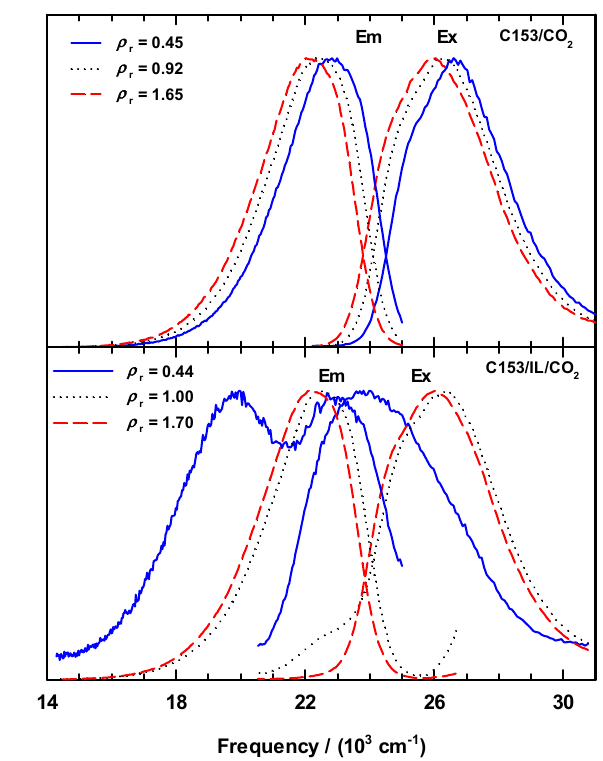
Figure 2. Excitation and emission spectra for C153 in scCO 2 and IL-modified scCO 2 at 323 K. Representative densities are chosen for values that are below, near and above the CO 2 critical density (solid, dotted and dashed lines, respectively). The upper panel is spectra of C153 in neat scCO 2 . Emission spectra were measured using ν ex = 27,397 cm − 1 . The excitation spectra were measured by